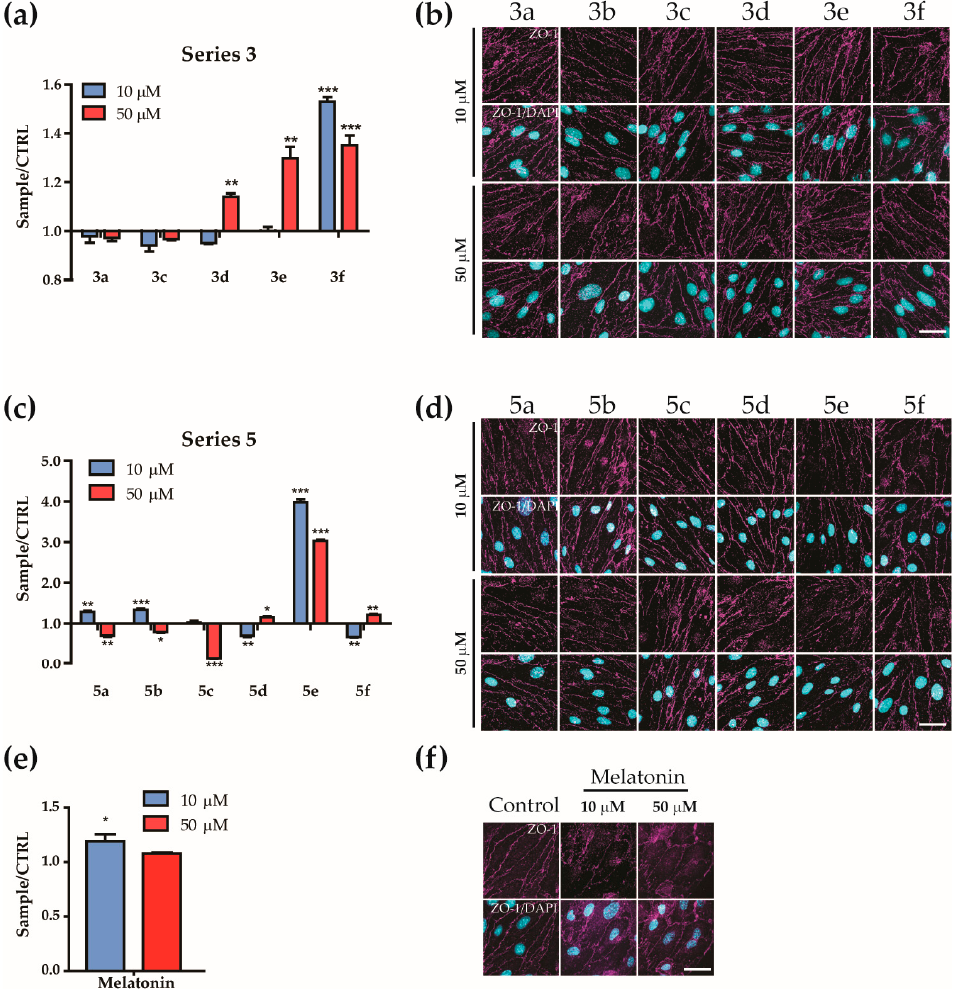
Figure 11. The bEnd3 blood–brain barrier model: Permeability of bEnd3 monolayer, treated with compounds 3a–f ( a ), compounds 5a–f, ( c ) or melatonin, ( e ) vs. control. The normalized control value was used as a baseline. Bars above the baseline indicate an increase in permeability; bars under the baseline indicate a decrease. Immunofluorescence of ZO-1 (tight junctions) of bEnd3 in vitro cell monolayer model, treated with series I ( b ), series II, ( d ) or melatonin ( f ). The cells were treated with 10 or 50 µM of the tested and reference compounds. ZO-1—magenta; DAPI (nucleus)—cyan. Scale bar—20 µm. Data are presented as means ± SD. * p < 0.05, ** p < 0.01, *** p < 0.001, vs. control. One- way analysis of variance and Dunnet’s post hoc test were used.